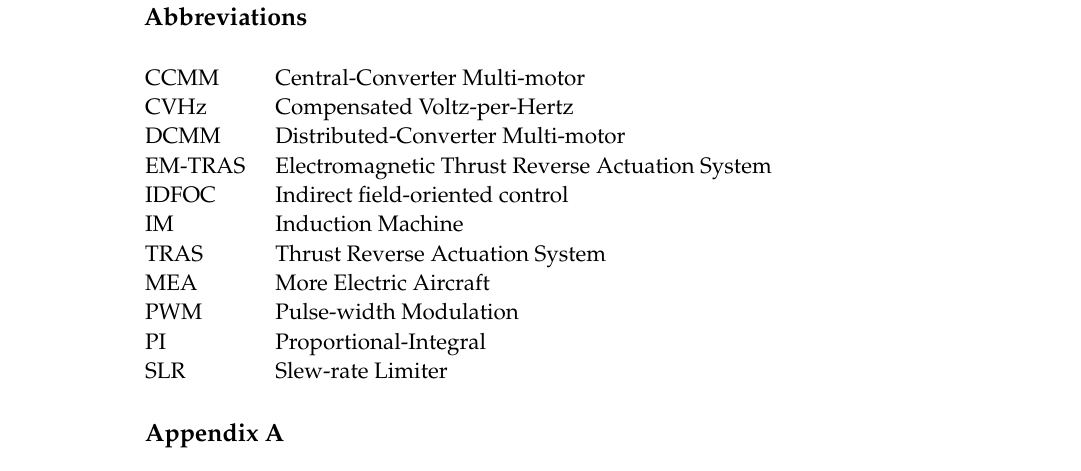
Table A1. Parameters for 15 hp Induction Machine.